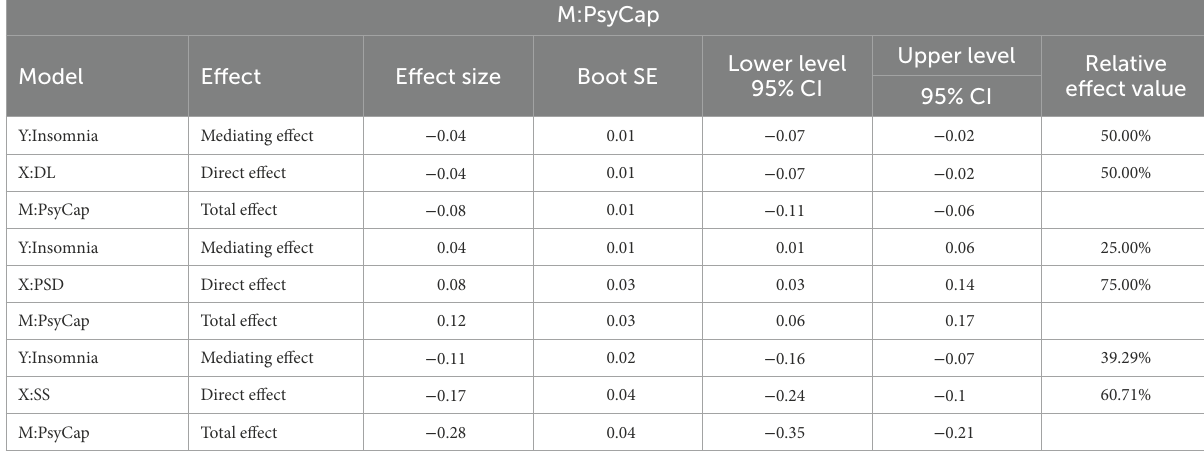
TABLE 3 The total effect, direct effect, and mediating effect of occupational stressors – psychological capital –